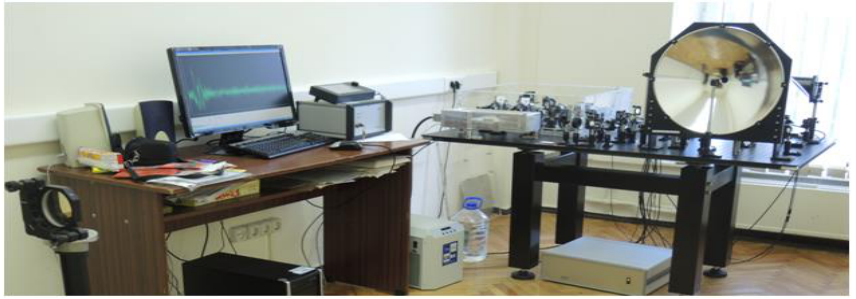
Figure 1. Setup for the experiment for measuring THz signals at long distance